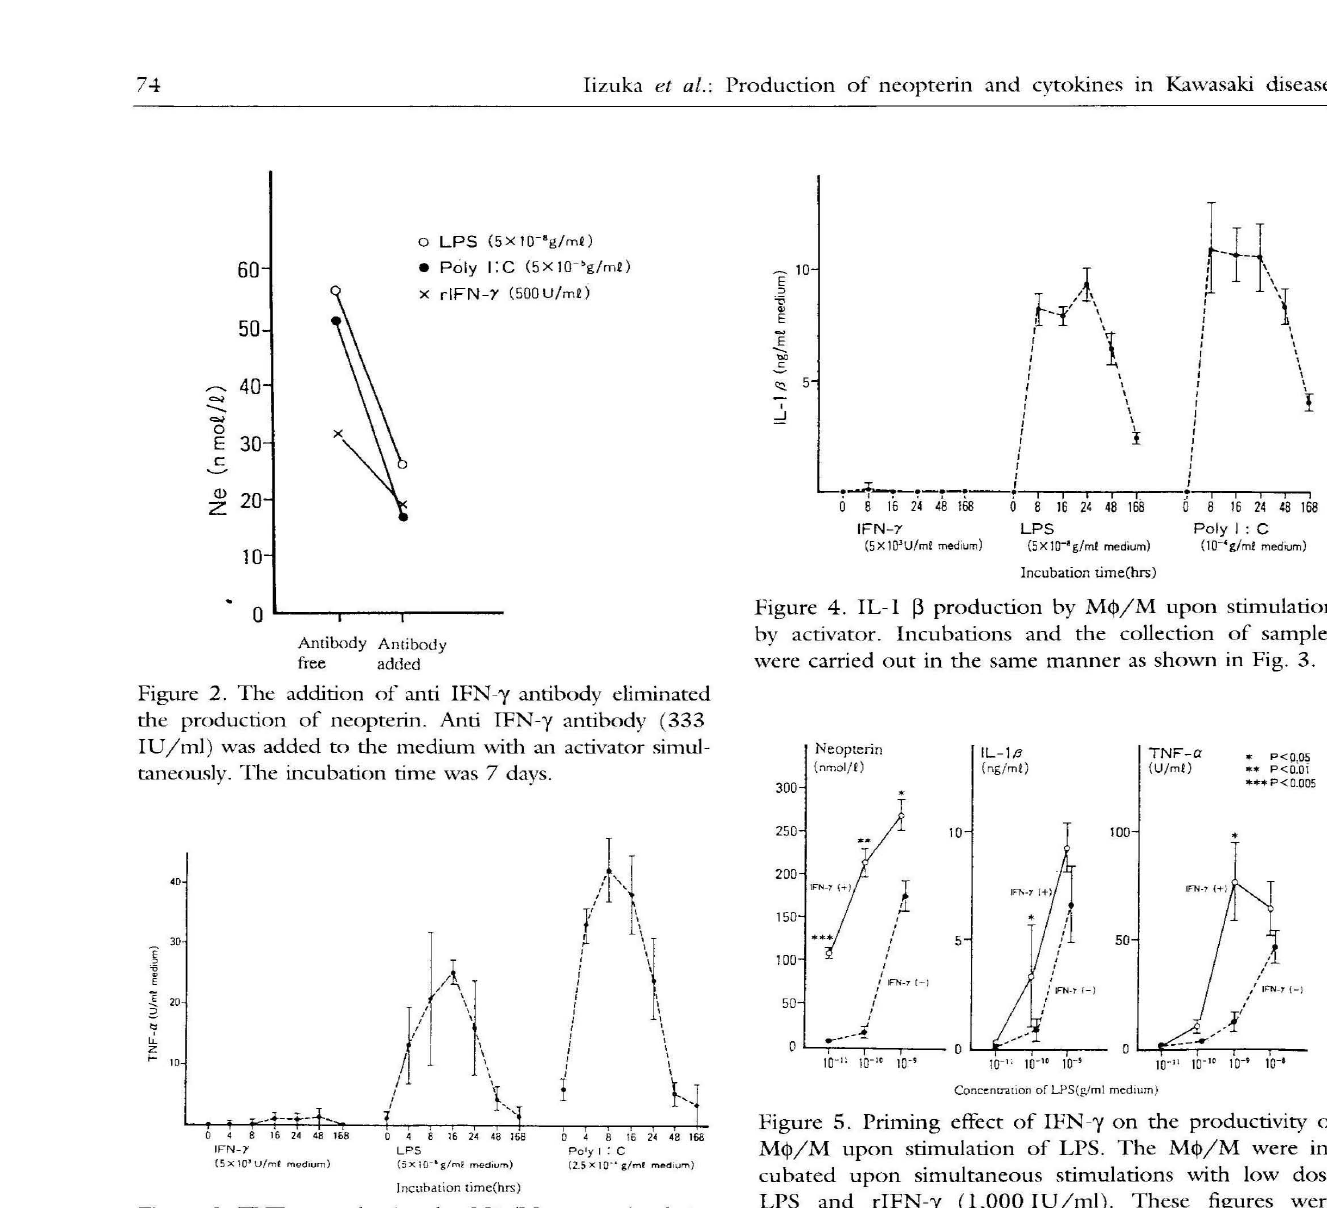
Figure 3. TNF-a production by M<j>/M upon stimulation by activators. Repeated incubations were carried out as shown in Fig. 1 and a 100 I-ll quantity of each of the su pernatants was obtained to examine TNr-a by the ELISA method at 0, 4, 16,24,48 and 168 hr after incubation.